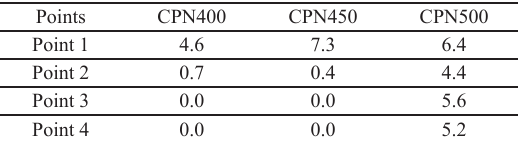
Table 3. Quantity of nitrogen (by wt%) at the interface points of the nitride samples. The position of the point is determined from the surface edge (point 1) towards the substrate with 0.006 coordinate advances.